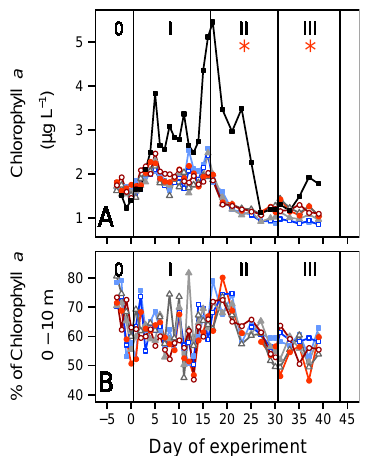
Figure 9. Temporal dynamics in (a) chlorophyll a (0–17m) includ- ing surrounding water and (b) percent of total chlorophyll a in the upper 10m. Colours and symbols are described in Table 1. Red as- terisks denote significant positive effect of CO 2 (* = p